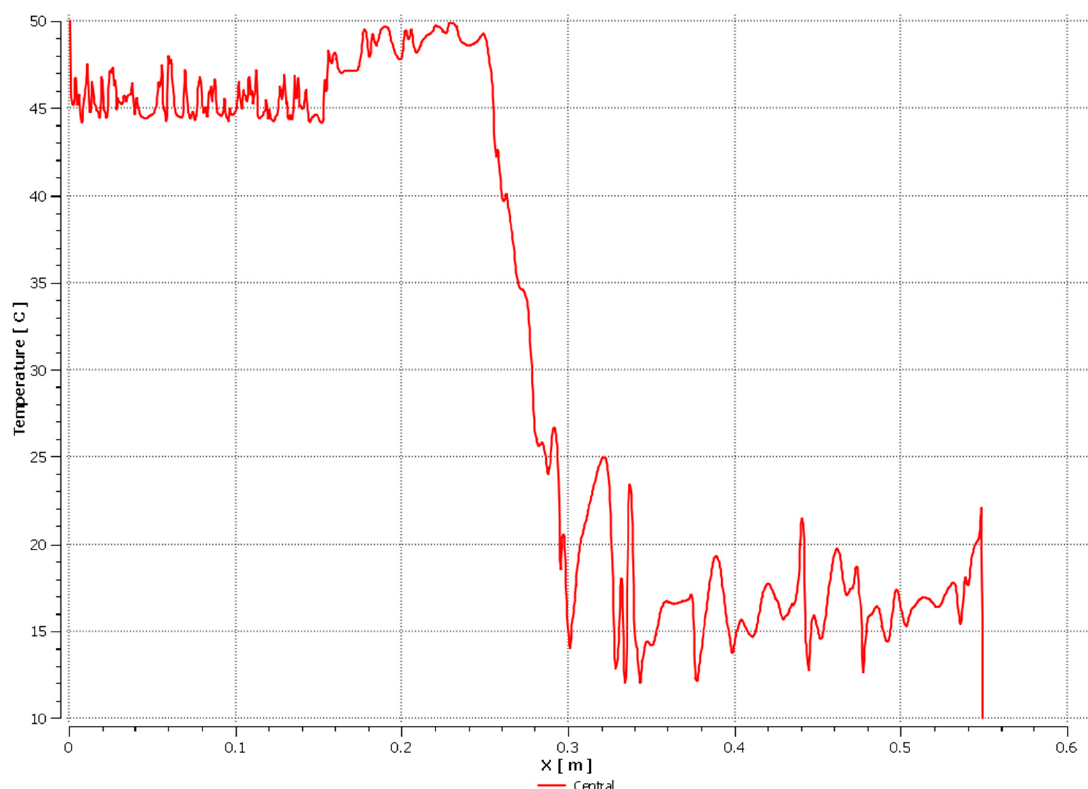
Figure 36. Temperature distribution along the height of the heat pipe’s wall.